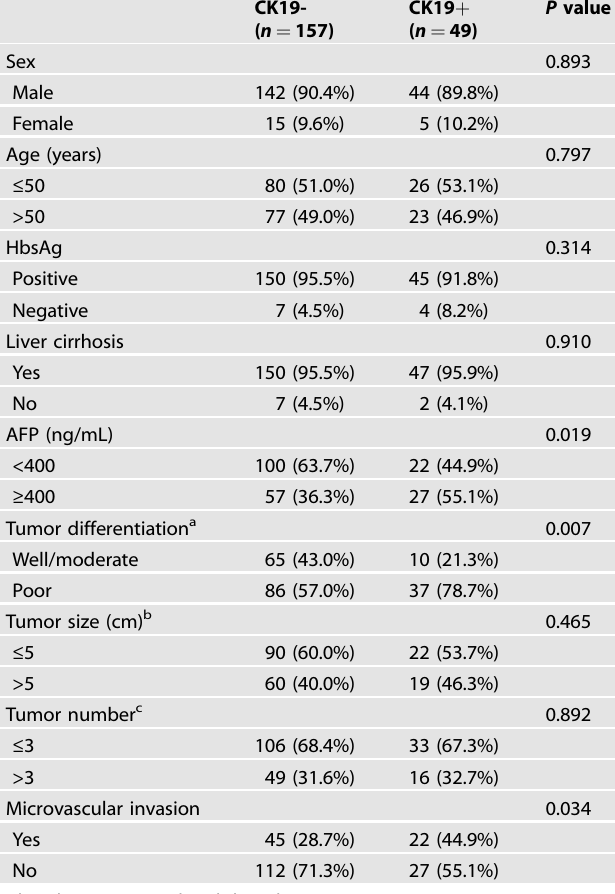
Table 1. Clinicopathological characteristics of patients with CK19 − and CK19 + hepatocellular